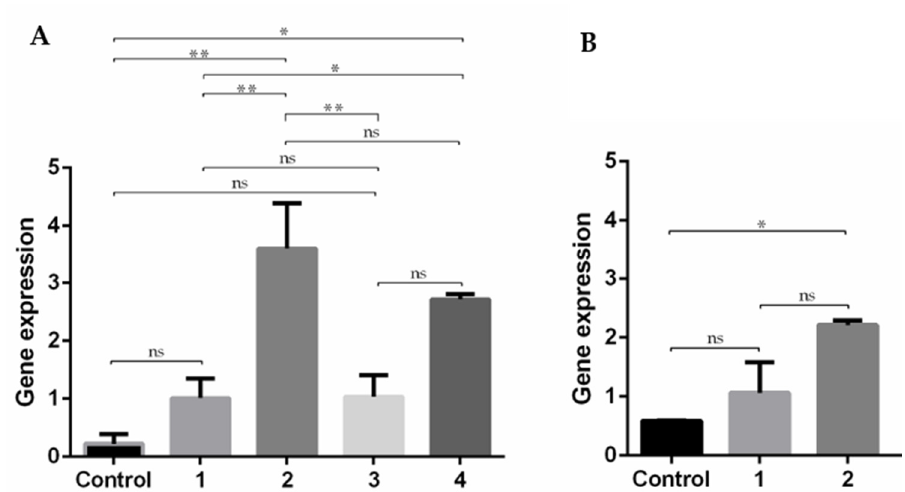
Figure 9. RT-qPCR of E7 expression levels in RAW 264.7 cells ( A ) and human fibroblast cells ( B ): Control–non-transfected cells; 1- PEI/mcDNA N/P ratio 5:1; 2- R8-mannose/PEI/mcDNA N/P ratio 2:5:1; 3- PEI/mcDNA N/P ratio 10:1; 4- R8-mannose/PEI/mcDNA N/P ratio 2:10:1. Data obtained from three independent measurements (mean ± S.D., n = 3); * p < 0.05; ** p < 0.01: ns—no significance.